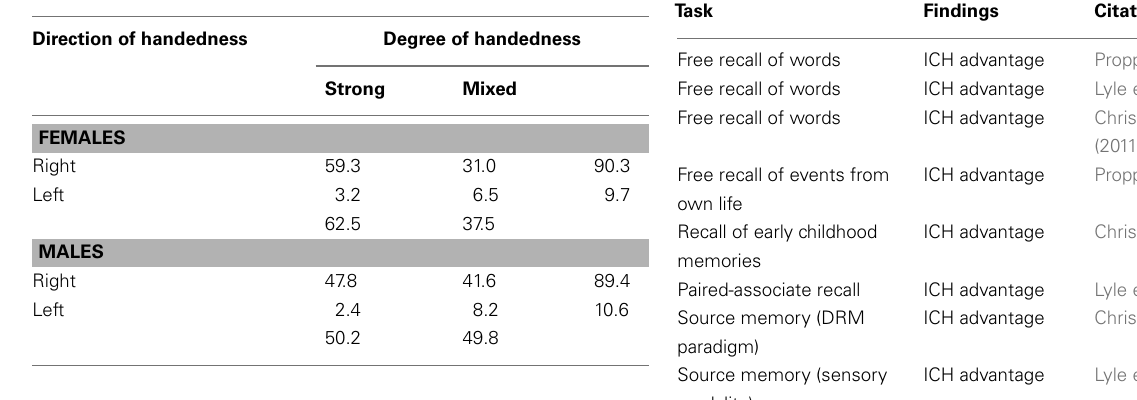
Table 2 | Summary of research on handedness differences in